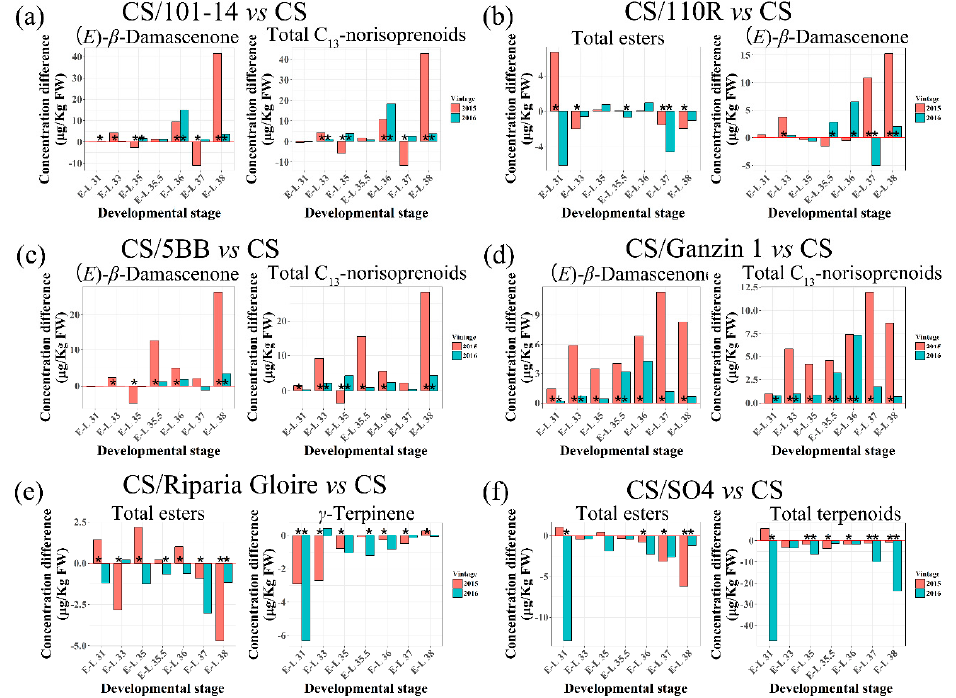
Figure 4. Effects of 101-14 ( a ), 110R ( b ), 5BB ( c ), Ganzin 1 ( d ), Riparia Gloire ( e ), and SO4 ( f ) on the volatile biomarkers in two seasons (2015–2016). Each data represent the concentration difference of volatile biomarkers between each grafted and own-rooted vines. The asterisk * in each bar indicates significant differences between grafted and own-rooted vines in the same season at the basis of student’s t -test at p < 0.05.